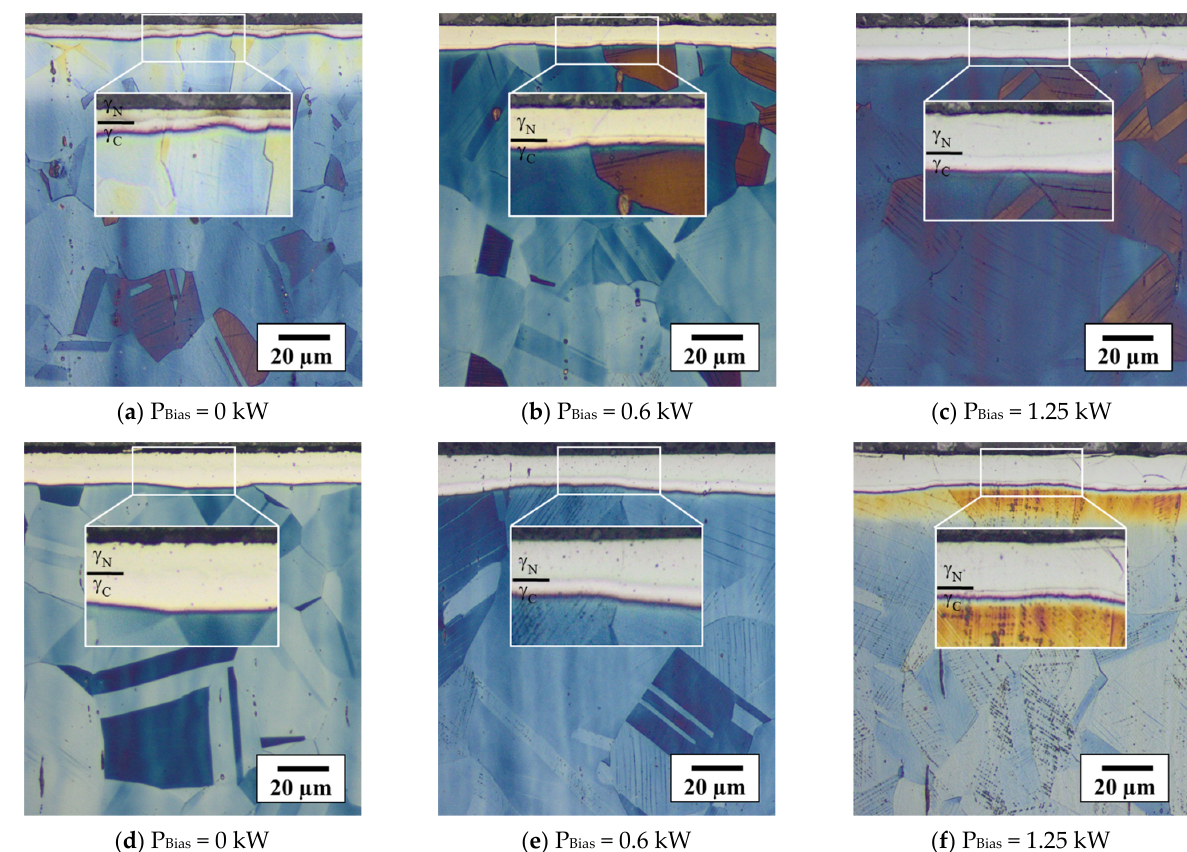
Figure 9. Cross-sectional optical micrographs of 316L after ASPNC by applying different bias conditions using a steel AS ( Φ CH4 = 4 slh) ( a – c ) and a CFC-AS ( d – f ) (etchant: Beraha II) at H 2 :N 2 = 1:1, p = 3 mbar, T = 460 °C, Φ Total = 80 slh, and t = 5 h.